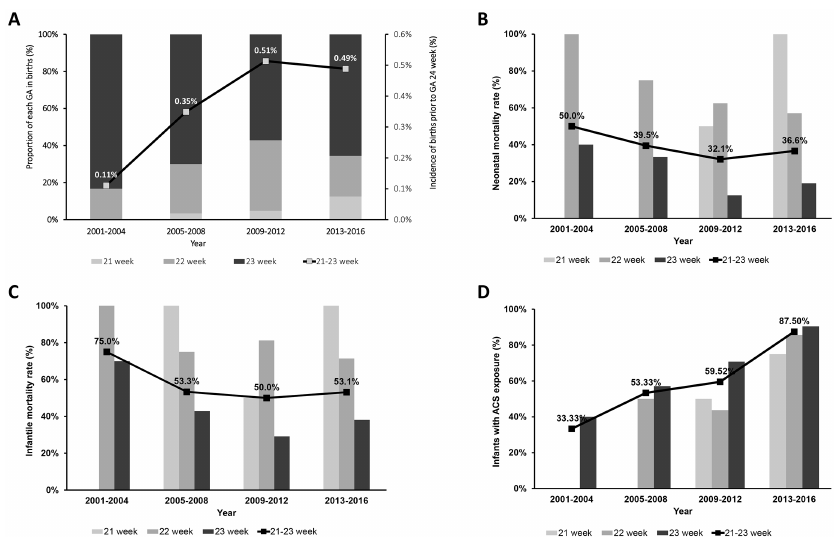
Fig 1. Incidence of preterm birth at 21–23 weeks of gestation, neonatal mortality rate, infant mortality rate, and rate of ACS administration in preterm births at 21–23 weeks of gestation according to the time period; 2001 to 2004, 2005 to 2008, 2009 to 2012, and 2013 to 2016. The incidence of preterm births at 21–23 weeks of gestation increased significantly over time (A). Neonatal mortality rate (B) and infant mortality rate (C) decreased over time, but without statistical significance. A significant increasing trend of ACS therapy was observed